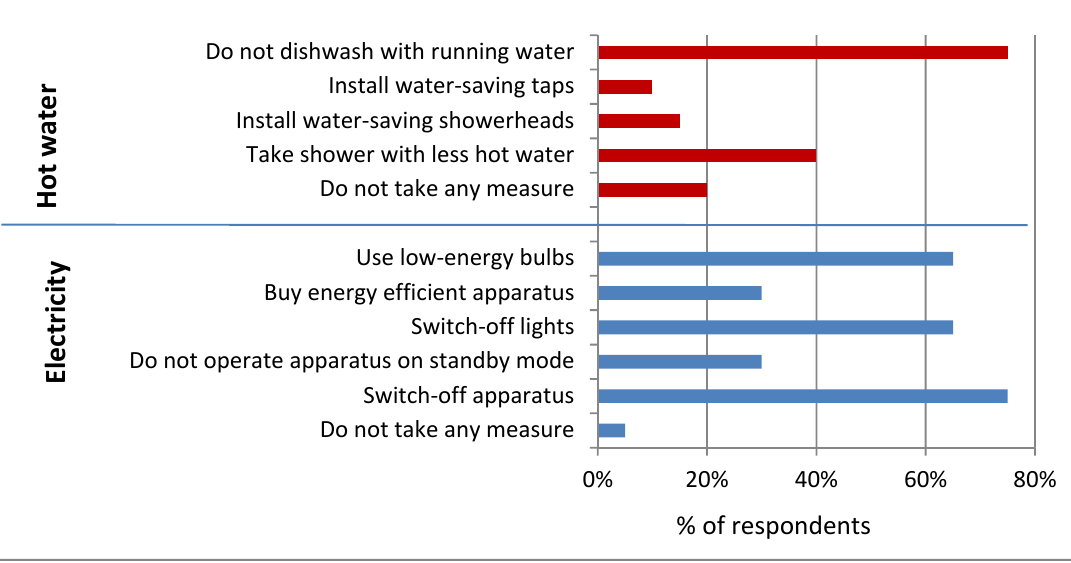
Figure 4. Measures taken by the tenants to reduce electricity and hot water use (the sum of percentages does not add to 100%, as it was possible to mark several